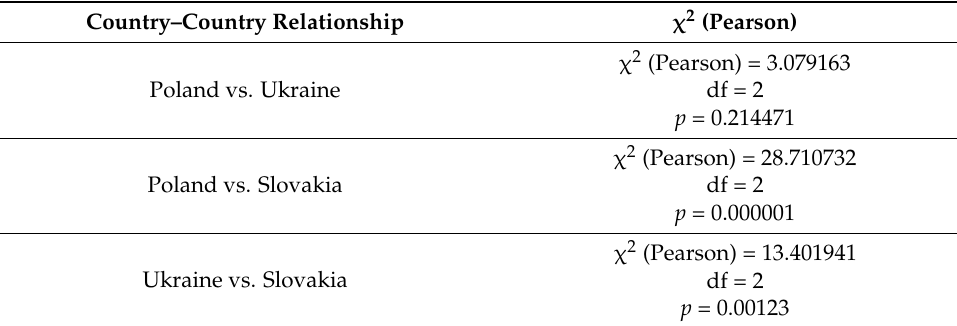
Table 2. Results of the χ 2 test for the relationship between the studied countries in the area of the problem of environmental degradation under